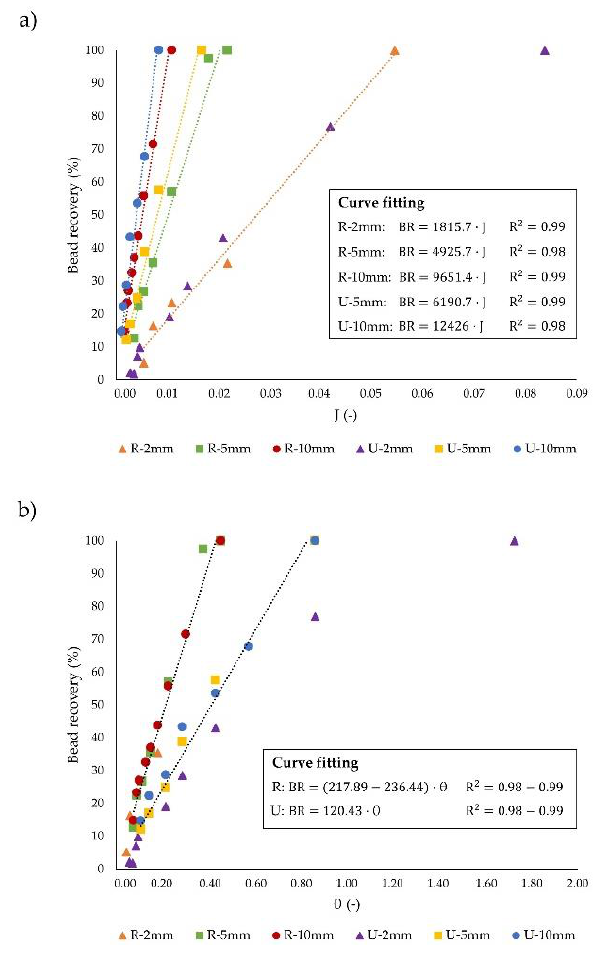
Figure 6. Influence of ( a ) magnetic and fluidic forces (J parameter) and ( b ) channel geometry (θ parameter) on particle recovery. Note that U-2mm does not accurately fit a line.